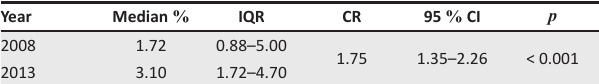
TABLE 3: Comparison of median within-herd prevalence in Streptococcus uberis - positive herds in 2008 ( n = 48) and 2013 ( n =